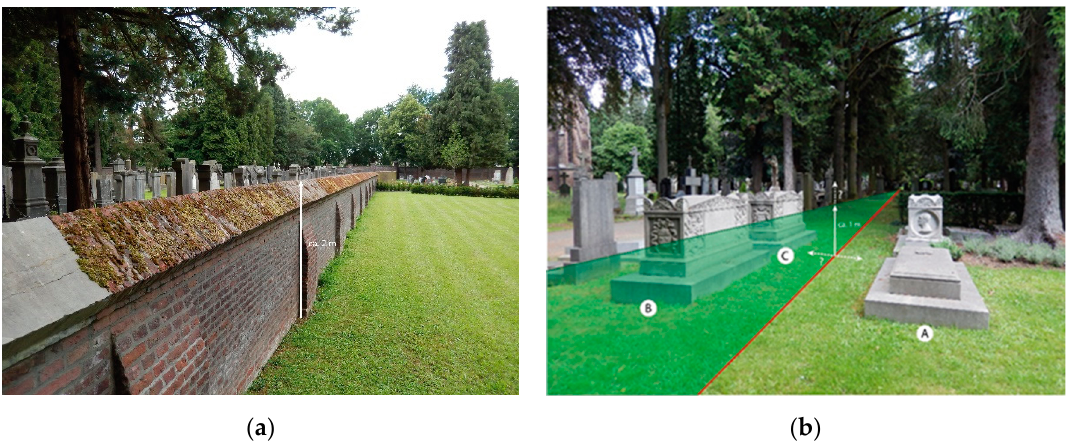
Figure 3. ( a , b ) . Detail of wall separating Jewish section (photograph: S.K.) and the MacPherson and Van Meeuwen sarcophagi (photograph: E.V.).